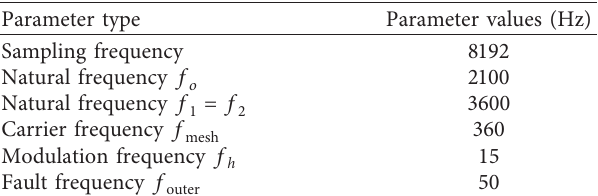
Table 2: Parameters of the simulated signal. Parameter